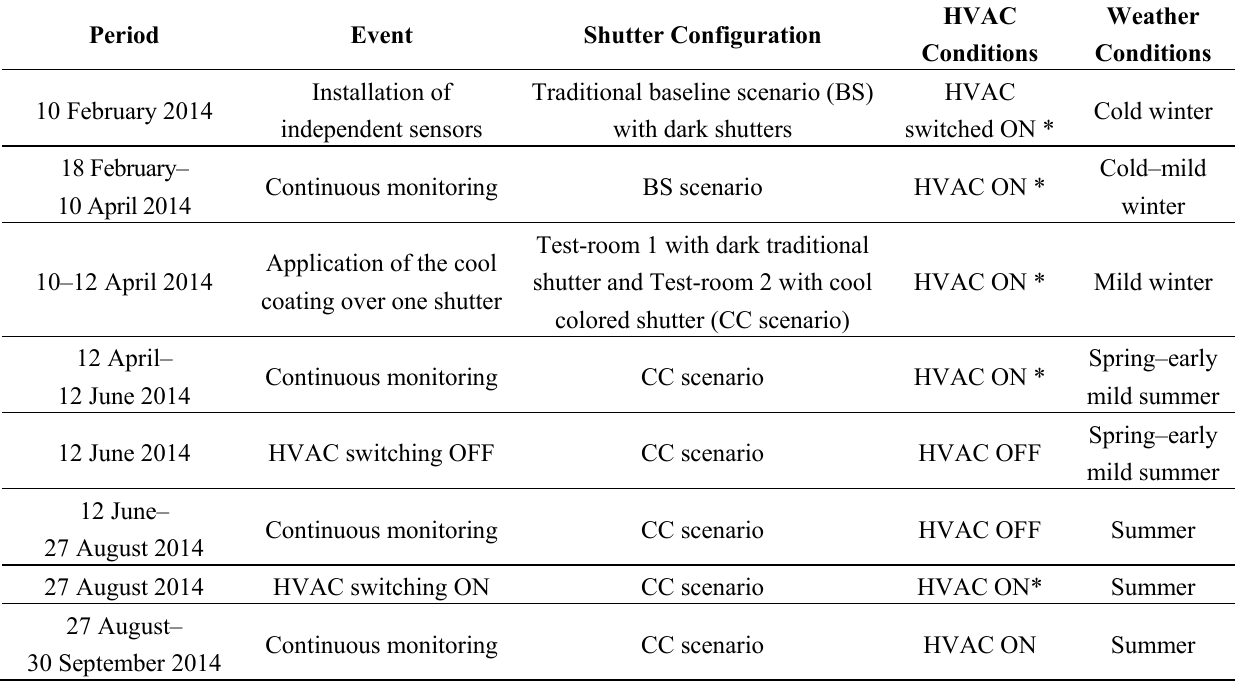
Table 1. Agenda of the continuous monitoring campaign.